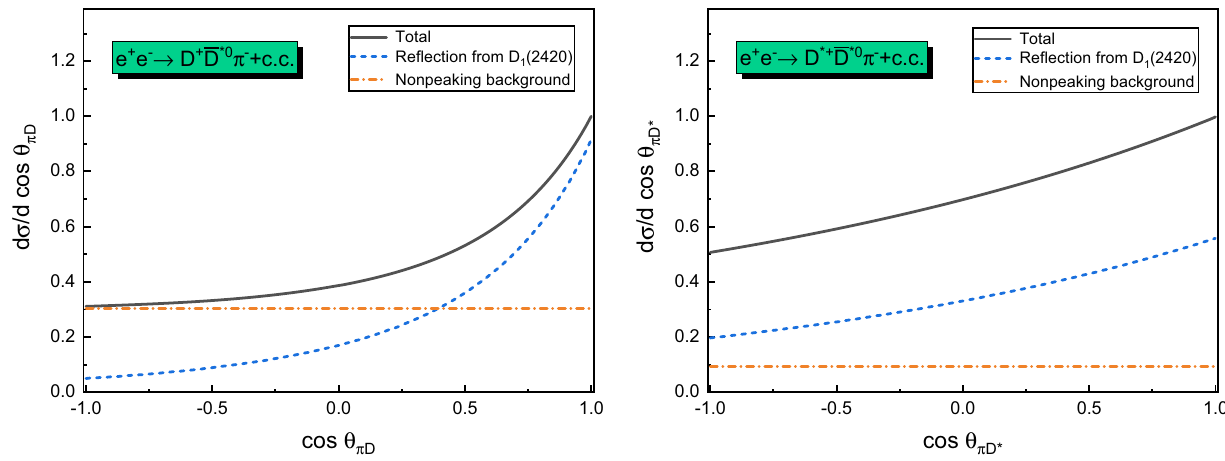
Fig. 5 The predicted differential cross sections of e + e − → D + ¯ D ∗ 0 π − and e + e − → D ∗+ ¯ D ∗ 0 π − vs. cos θ π D and cos θ π D ∗ , respectively. Here, the maximums of angular distributions are normalized to one